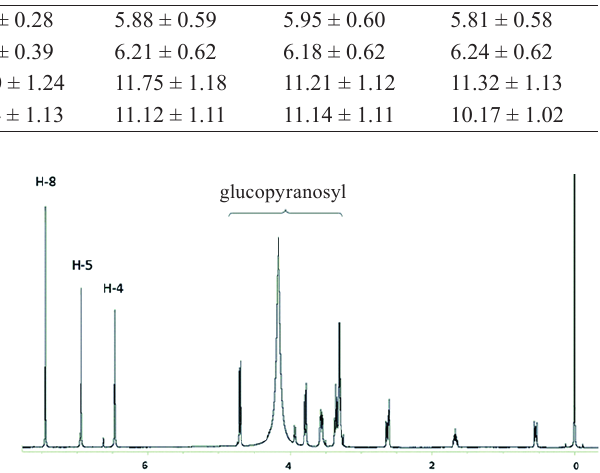
Table 6 Temperature selection for extracting biologically active substances from ginseng root cultures Temperature, °С Extract yield depending on duration, %